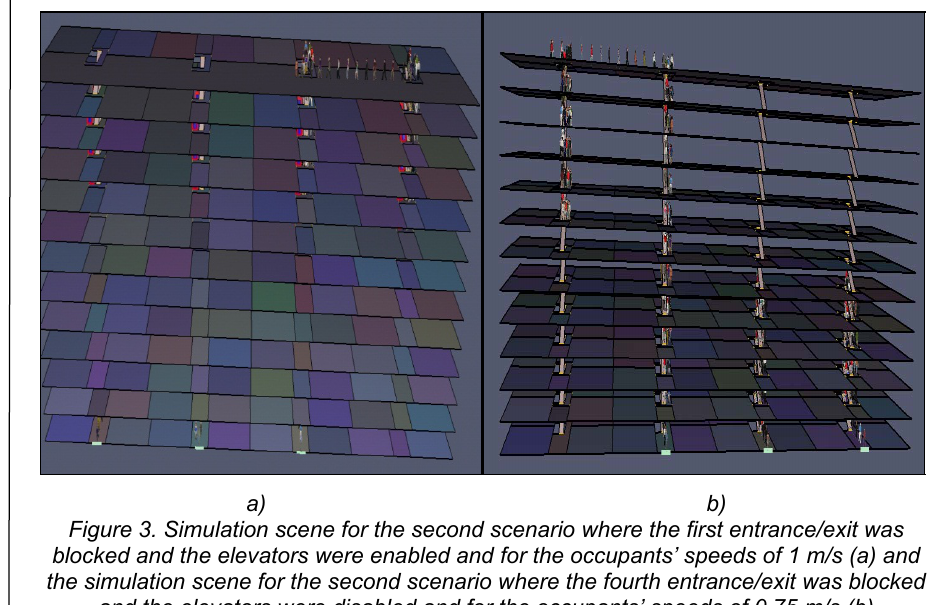
Figure 3. Simulation scene for the second scenario where the first entrance/exit was blocked and the elevators were enabled and for the occupants’ speeds of 1 m/s (a) and the simulation scene for the second scenario where the fourth entrance/exit was blocked and the elevators were disabled and for the occupants’ speeds of 0.75 m/s (b) Рис . 3 – Имитационные сцены по второму сценарию , в котором первый вход / выход заблокирован и есть лифты , учитывая скорость жильцов : 0.75 м / с , 1 м / с , 1.25 м / с , 1.5 м / с и 1.75 м / с ( а ), и имитационные сцены по второму сценарию , в котором четвертый вход / выход заблокирован и нет лифта , учитывая скорость жильцов : 0.75 м / с , 1 м / с , 1.25 м / с , 1.5 м / с и 1.75 м / с ( б ) Слика 3 – Симулационе сцене из другог сценарија где је први улаз излаз